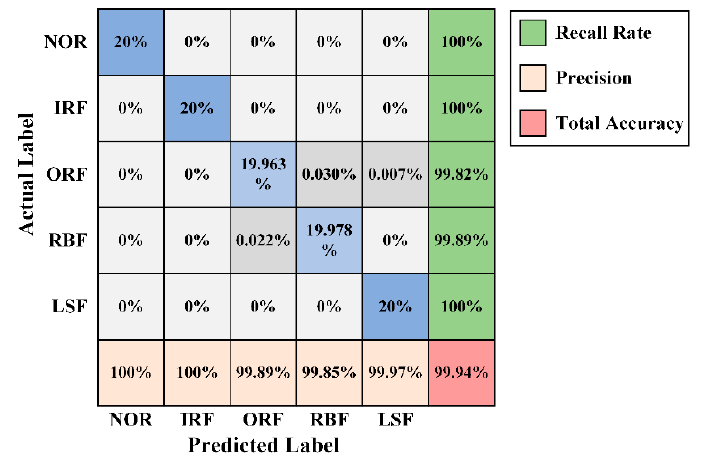
Figure 16. Confusion matrix of the best trial of WPT-CNN in Case Two.